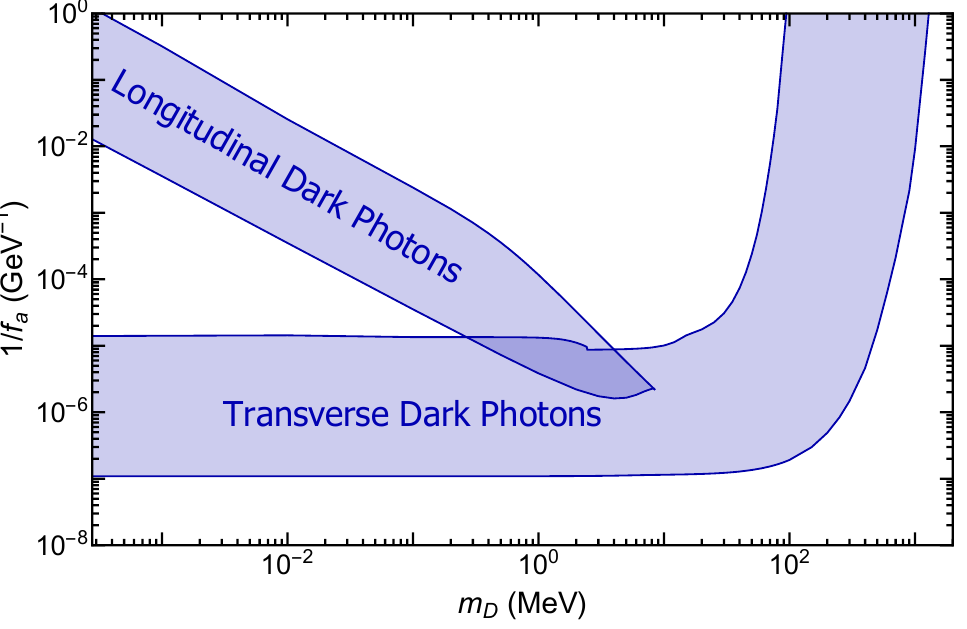
Figure 7 . A plot of the longitudinal and transverse constraints as a function of dark photon mass. The transverse constraints are analogous to those shown in figure 5. The longitudinal constraints are found by applying the bulk emission constraint and the trapping constraint to longitudinal dark photons